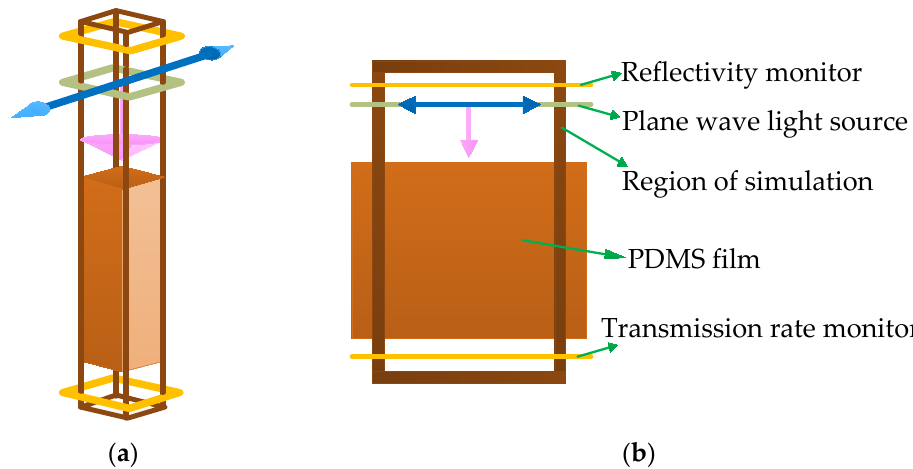
Figure 3. Model of PDMS film. ( a ) 3D modeling diagram for PDMS materials; ( b ) XZ interface coordination scale with “zoom extent”.